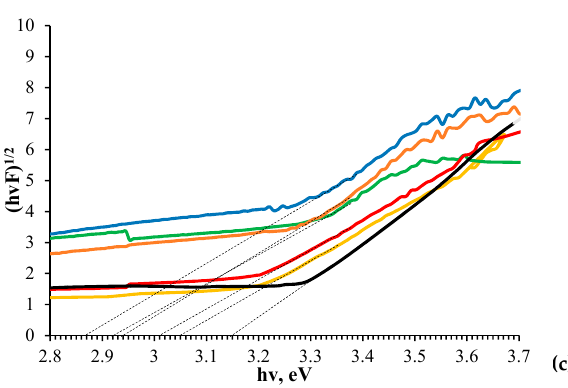
Figure 6. ( a ) UV-Vis Light Diffuse Reflectance spectra (DRS); ( b ) DRS spectra; ( c ) E g values, calculated with Kubelka–Munk method of [PP@AA-TiO 2 ] A photocatalysts containing different AA from 0 to 3.4 wt %.